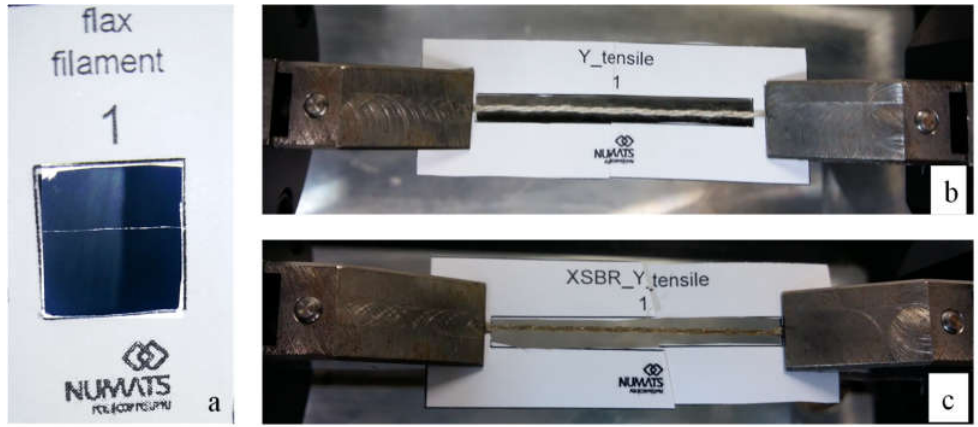
Figure 4. Flax specimens tested in tension: ( a ) filament; ( b ) non-impregnated yarn; ( c ) impregnated yarn.